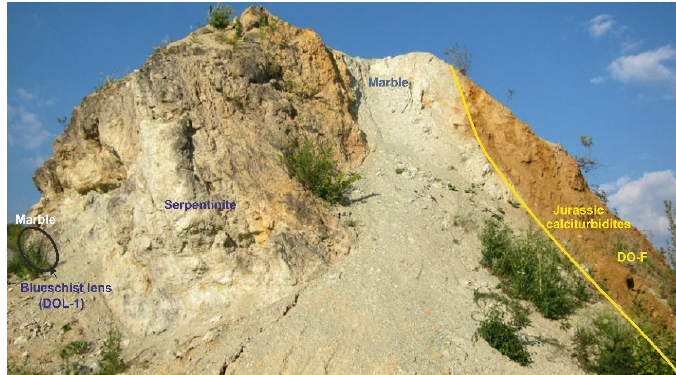
Figure 4. The Dobšiná quarry serpentinitic mélange block with a 4 m long blueschist lens in contact with marble and Tlc ‐ Chl ‐ Phg ‐ Cal schist fragments and Jurassic calciturbidite deposits. Further to the S of Dobšiná, below the Malý Radzim Silica Nappe outlier (near Brdárka locality), the blueschists (sample MR ‐ 1) associate with rare cherts (Figure 2). The Permian siliciclastics, rhyolitic volcanoclastics, and mid ‐ Triassic marbles in their vicinity are assigned to the Bôrka Nappe [8].